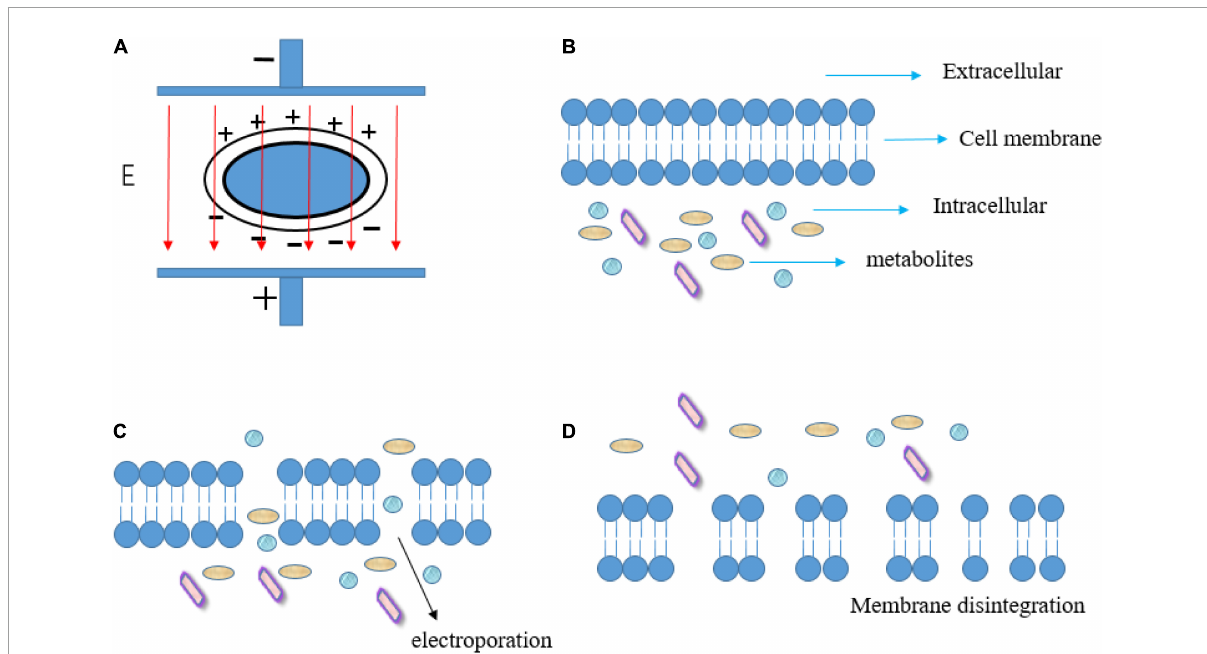
FIGURE1 Schematic diagram of transmembrane potential induced by PEF (A) , membrane before electroporation (B) , electroporation of cell membrane (C) , and membrane disintegration induced by excessive PEF treatment (D) . Adapted from Mahesha et al.